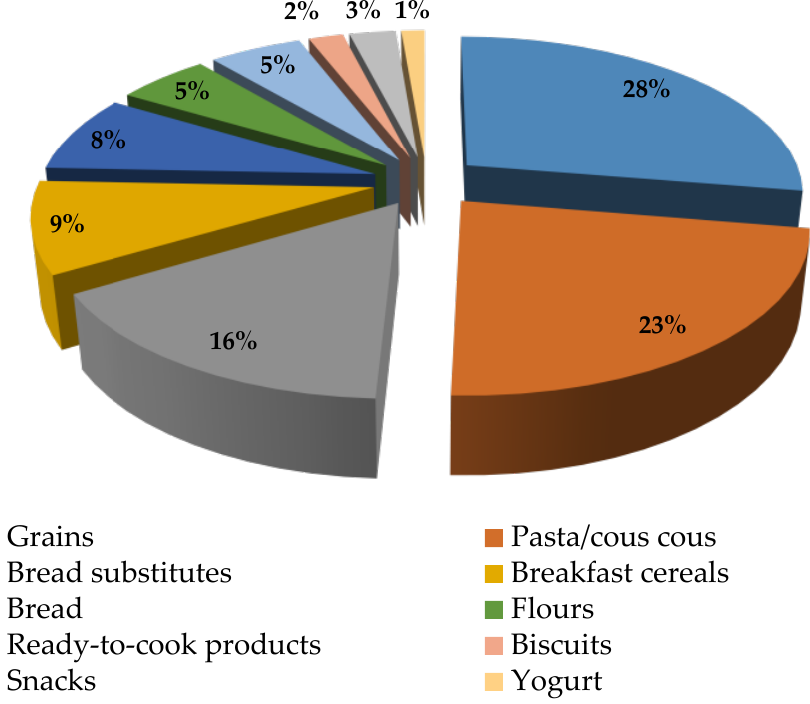
Figure 1. Distribution of quinoa products across product categories.